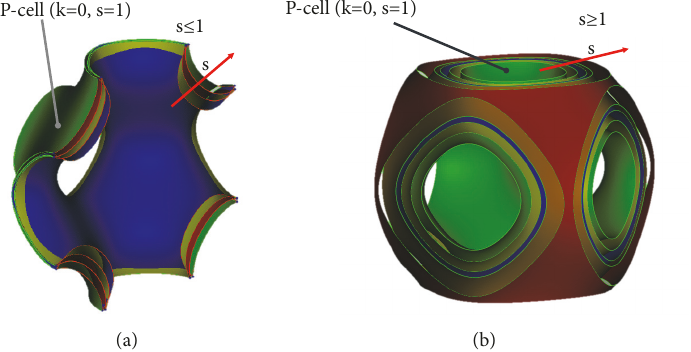
Figure 2: Several P-cells ( 𝑘 = 0 ) obtained varying the s parameter.